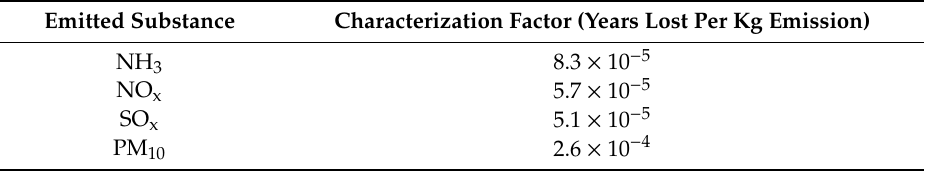
Table 4. Characterization factors for health e ff ects of PM, NH 3 , NOx and